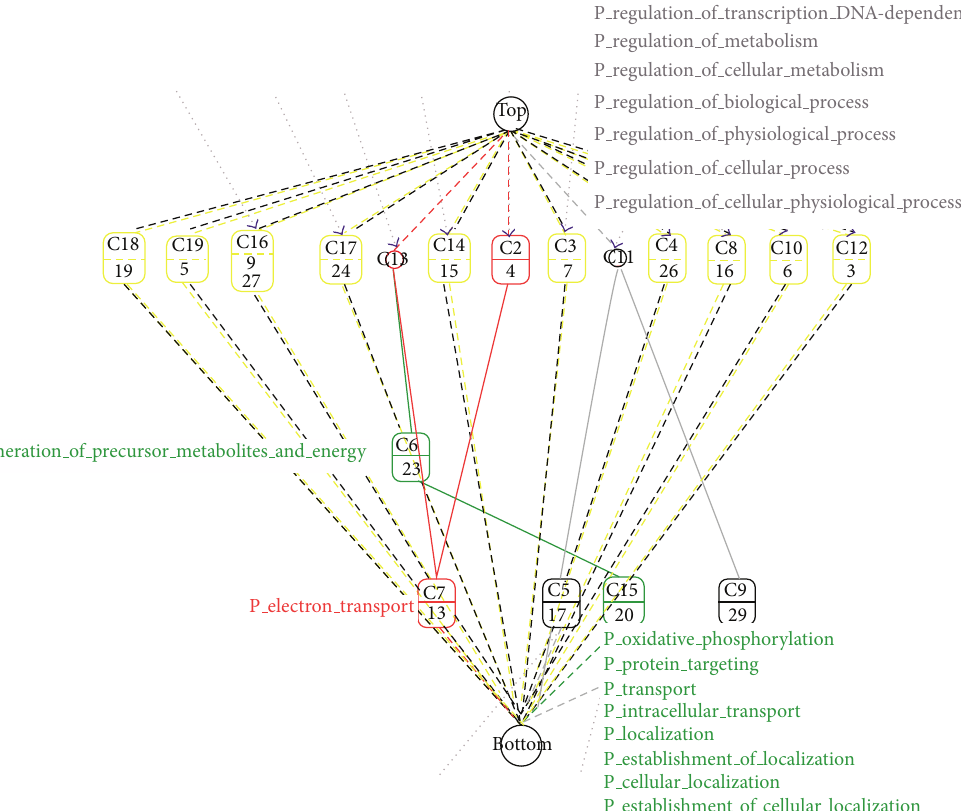
Figure 5: BioLattice analysis of RNA-seq data of lung tissues from COPD and control subjects. Each node indicates significantly enriched GO terms with 𝑃 values < 0.01. Lines indicate significant sharing of genes within two nodes, which indicates similarity of two enriched GO terms with respect to differentially expressed